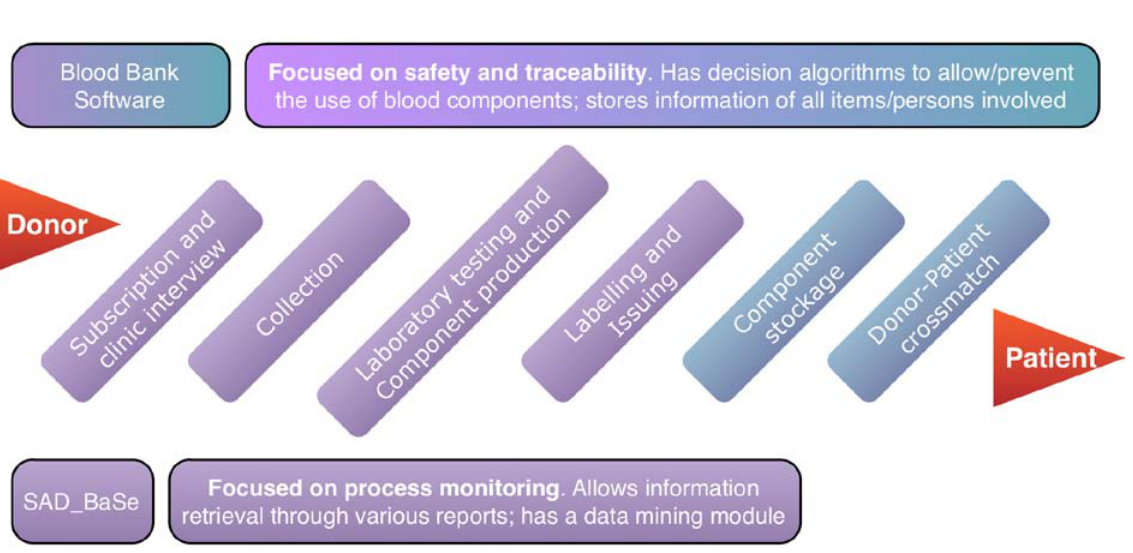
Figure 2: Blood chain from donor to patient and the non-overlapping activities of existing data processing systems and